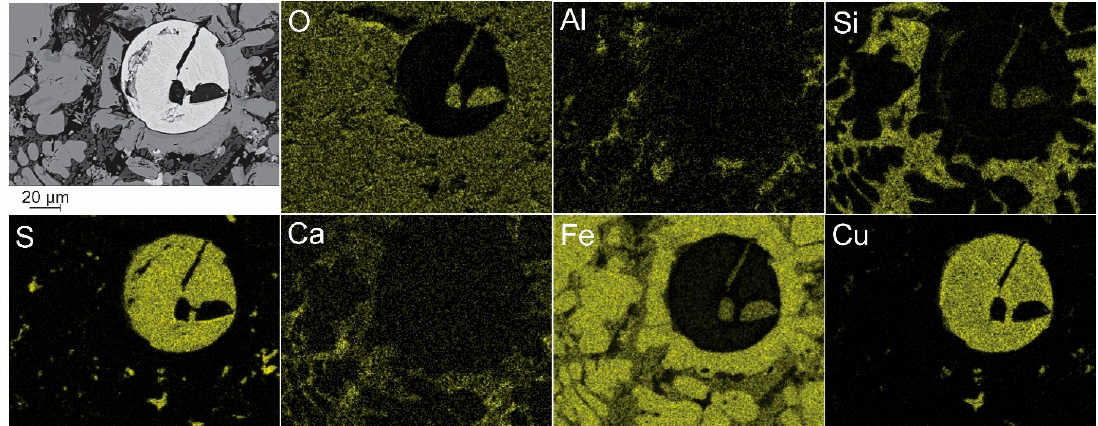
Figure 11. SEM-EDS maps of magnetic slag, of the area displayed in Figure 10b. First image is SEM-BSE.